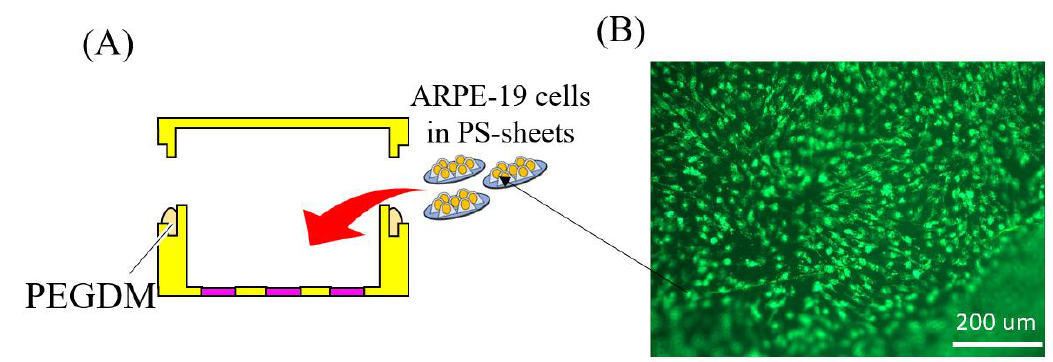
Figure 5. Cellular viability of ARPE-19 cells inside cell encapsulation capsule. ( A ) Conceptual image of the cell cultured PS sheets encapsulation process. ( B ) Image of ARPE-cells in 5 mm PS sheets on day 3.